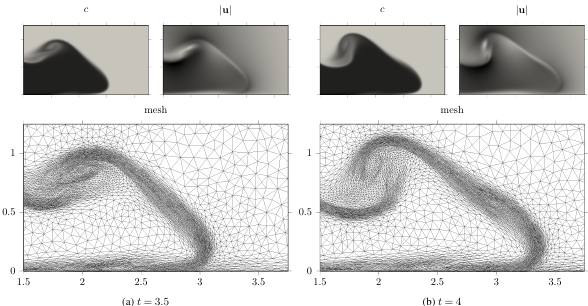
Figure 8. Images showing concentration c , velocity magnitude | u | , and the adapted mesh at t = 3 . 5 (a) and t = 4 (b) over the subdo- main, 3 . 5 < x < 3 . 75, z < 1 . 25 on a y normal plane at y = 0. ∆ x